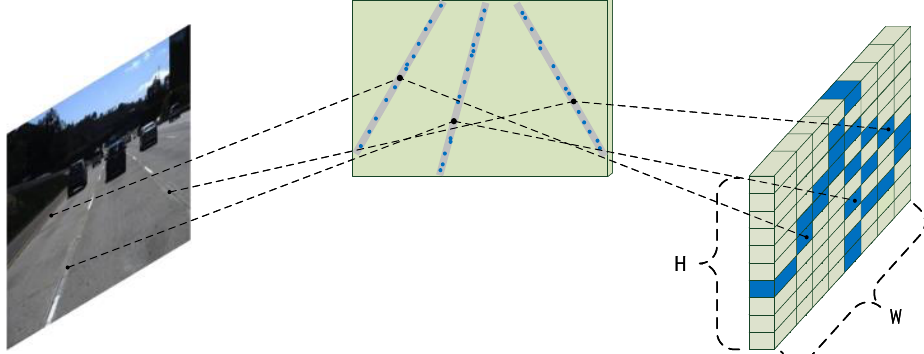
Figure 5. Illustration of key points prediction. ‘Green’ grids are background pixels, and the grids marked ‘blue’ are key points of the lane